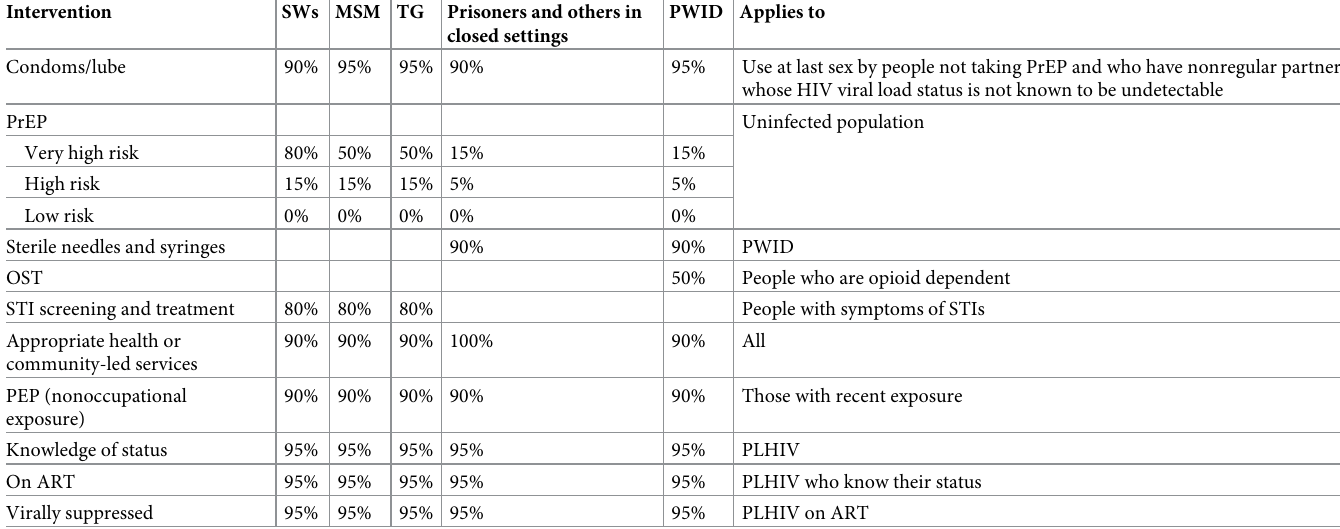
Table 3. 2025 targets for key